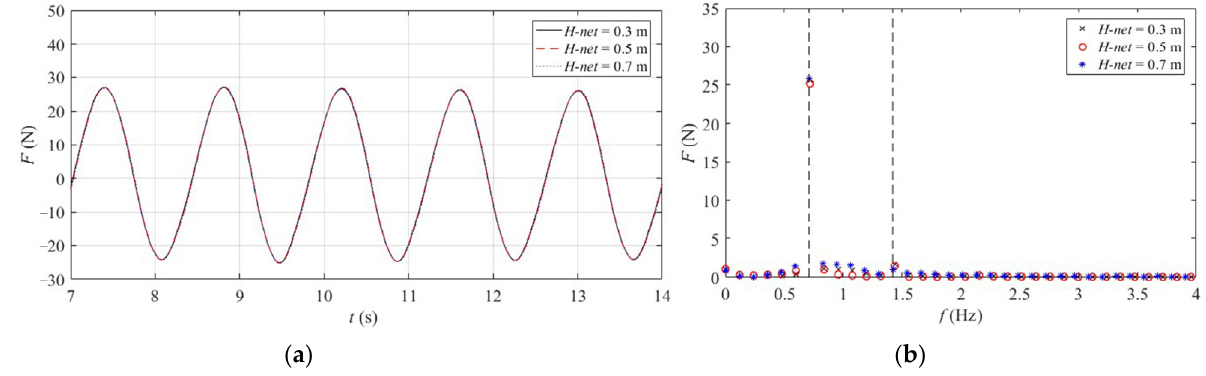
Figure 9. Load duration curve and spectrum of combined structure under different cage heights. ( a ) Time domain curve. ( b ) Frequency domain diagram.